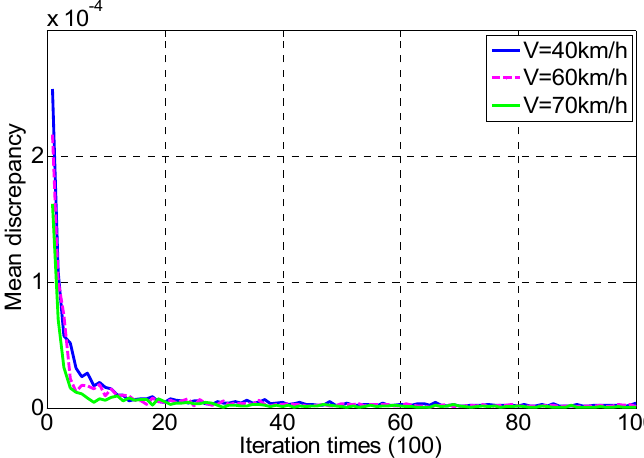
Figure 8. Mean discrepancy of the Q-values.